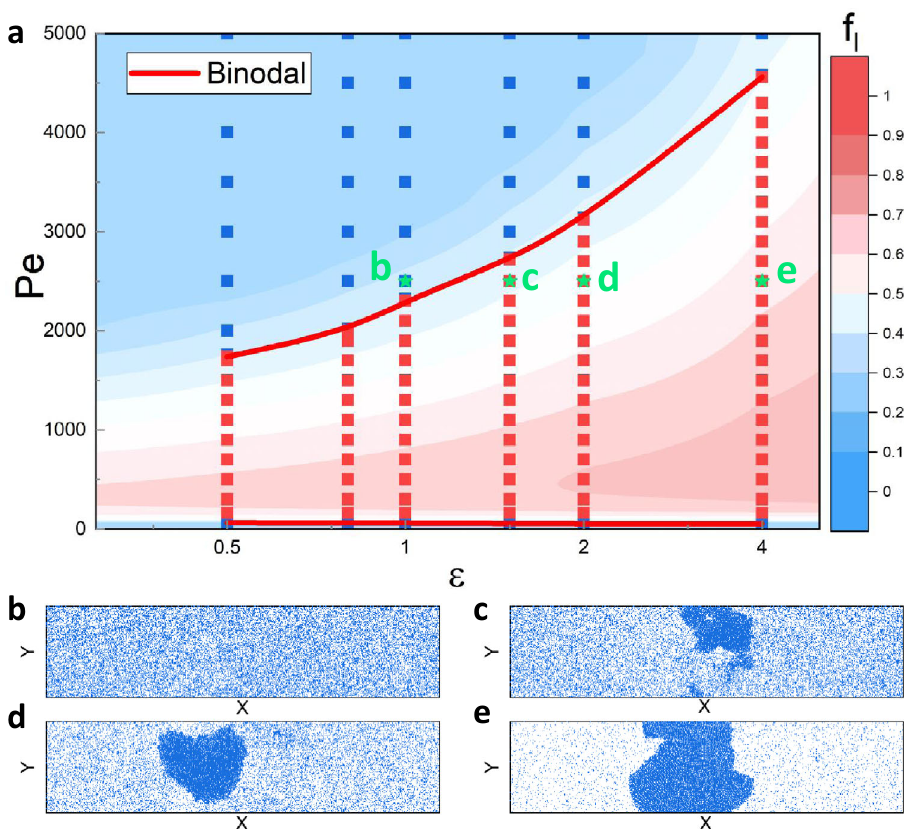
Fig. 2 In fl uence of the interaction strength. a Phase diagram in the Pe − ϵ plane at ϕ = 0.3. The colored background is obtained by the kinetics model. The blue symbols represent the single phase, the red ones denote MIPS and the red-line boundaries is the binodal curves, which are all obtained by simulations. The steady-state con fi gurations at Pe = 2500 and b ϵ = 1.0, c 1.5, d 2.0 and e 4.0 are respectively marked as green stars in a